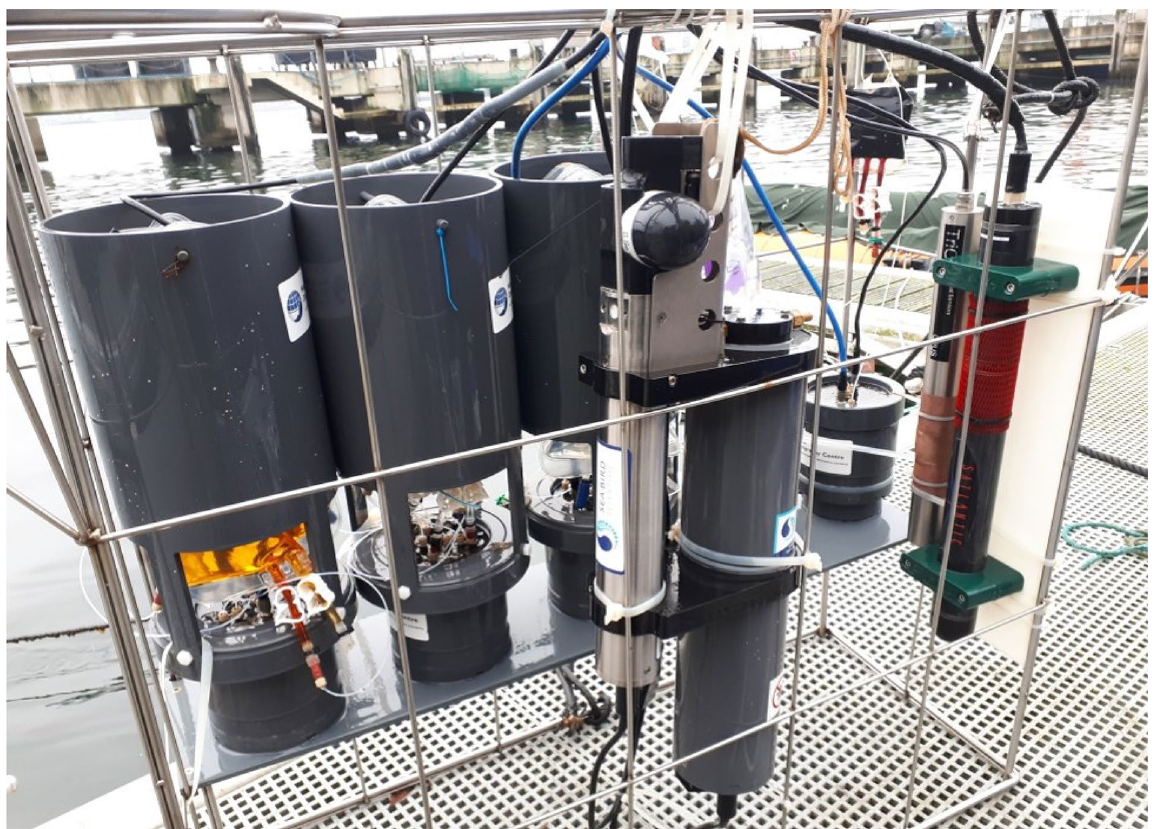
Figure 8. Deployment setup after recovery with the DMn LoC analyser on the left and SeapHOx unit in the